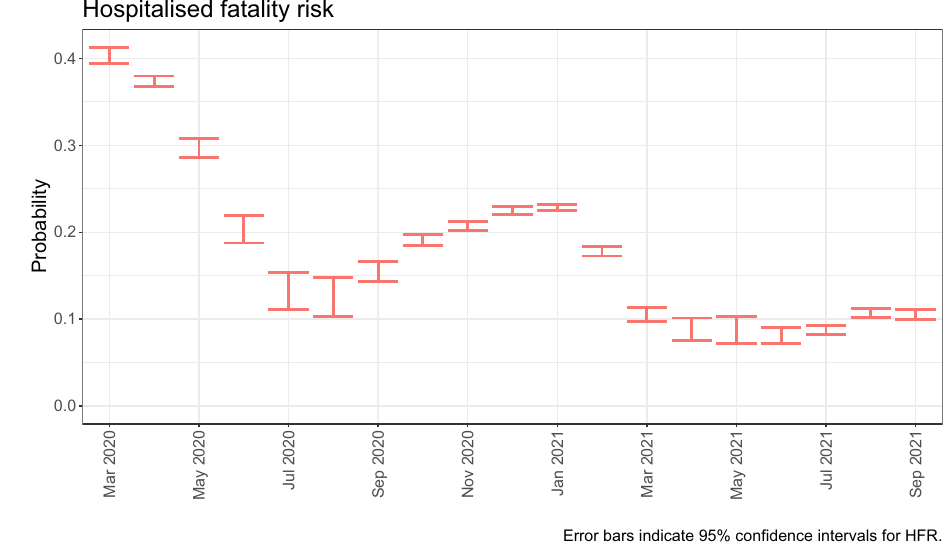
Error bars indicate 95% confidence intervals for HFR.